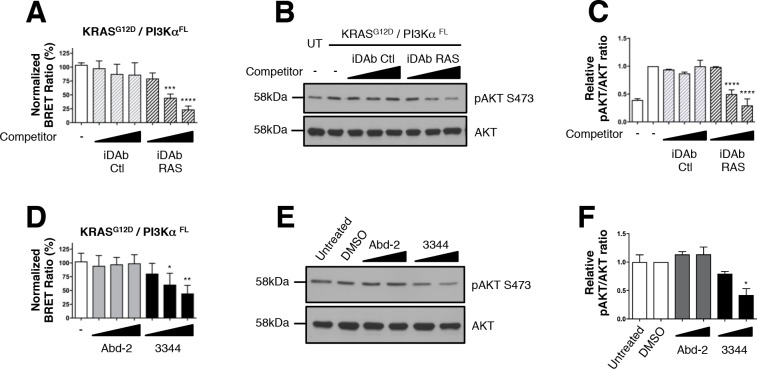
Interaction between mutant KRAS and full-length PI3Kα BRET pair interaction is impeded by 3344.The BRET signal produced from the interaction of the KRASG12D and full-length PI3Kα (PI3KαFL) was obtained by transfecting HEK239T cells with plasmids encoding this BRET pair. In A, cells were co-transfected with the biosensor and increasing levels of competitor plasmids encoding iDAbs RAS (black striped bars) or iDAb control (grey striped bars) or biosensor alone (white bar). iDAb RAS impedes KRASG12D/PI3KαFL interaction and this inhibition causes a decrease of pAKT at serine 473 as shown by western blot in B and its quantification in C. UT is for untransfected cells. In D, HEK293T cells transfected with the BRET biosensor KRASG12D/PI3KαFL were treated for 20 hr with DMSO (white bar), 5, 10 and 20 μM of Abd-2 (grey bars) and 3344 (black bars) compounds and the BRET signal of the biosensor was assessed. In panel E, the cells were transfected and treated as in D but with 10 and 20 μM of Abd-2 and 3344 compounds. 20 hr after the treatment, cells were lysed and analysed by western blot using anti-pAKT (Ser 473) or anti-pan-AKT antibody. The signal in the western blot is quantitated in F. Related controls are shown on Figure 4—figure supplement 1. One-way ANOVA followed by Dunnett’s post-hoc tests were used to determine the statistical significance of BRET and pAKT modulations induced by the compound or the iDAb (*p<0.05, **p<0.01, ***p<0.001, ****p<0.0001). Each experiment was repeated twice (E–F) or three times (A–D). Where error bars are presented, they correspond to mean values ± SD of biological repeats (A, D) or correspond to mean ±SEM of biological repeats (C, F). See also Figure 4—figure supplement 1.